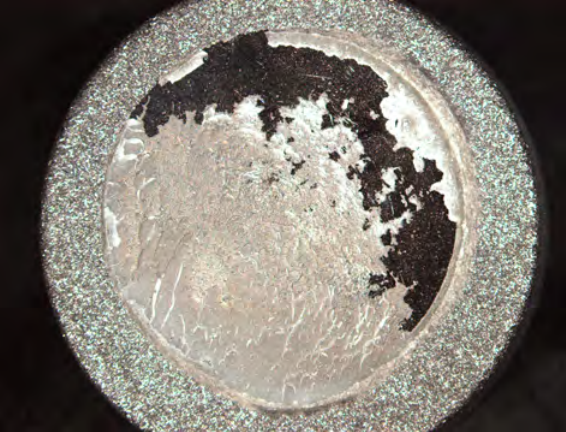
Figure 1. Stainless steel AISI 316L.